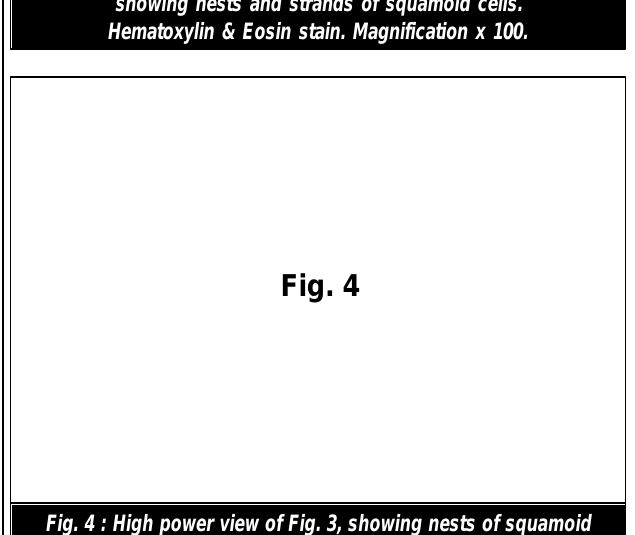
Fig. 4 : High power view of Fig. 3, showing nests of squamoid cells with stratification and keratin (arrow). Hematoxylin & Eosin stain. Magnification x